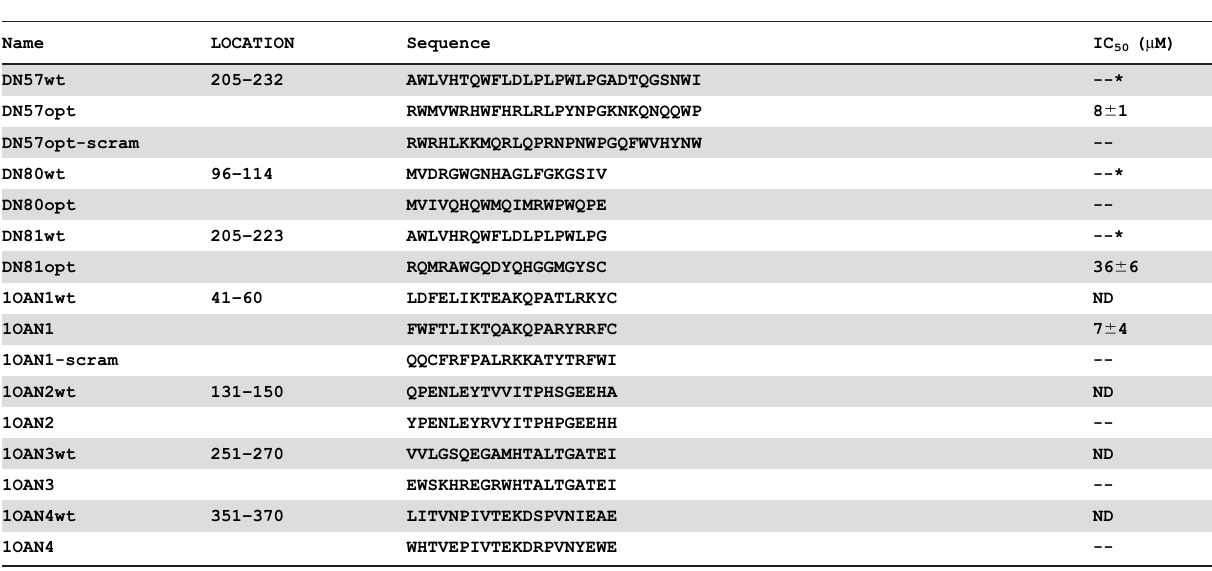
Table 1. Sequences and IC 50 values of